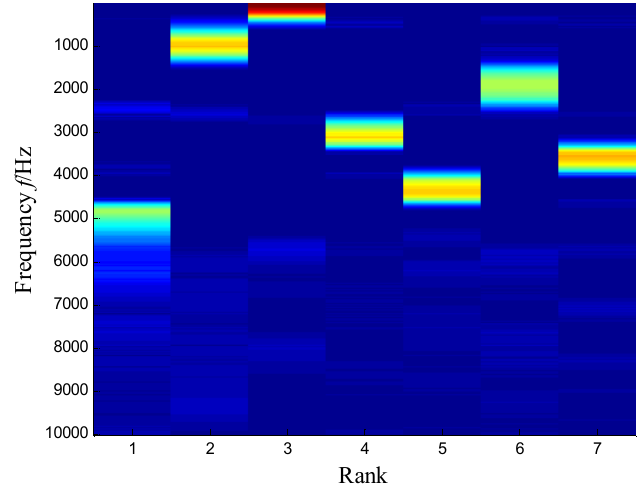
Figure 23. Coefficient matrix heat map obtained by KNMF. However, the sparseness of matrix V derived by KNMF was not as good as that of SKNMF, shown in Figure 5. Since the weight distribution of the subspace was not concentrated, a seventh subspace with the larger weight value was selected, and the extracted subspace is shown in Figure 24. Figure 25a,b shows the spectrum and the envelope spectrum of the extracted signal. Compared with Figure 7b, the extracted feature frequency bandwidth of KNMF was wider than that of SKNMF, which led to the defect feature KNMF extracted not being as clear as what SKNMF extracted.